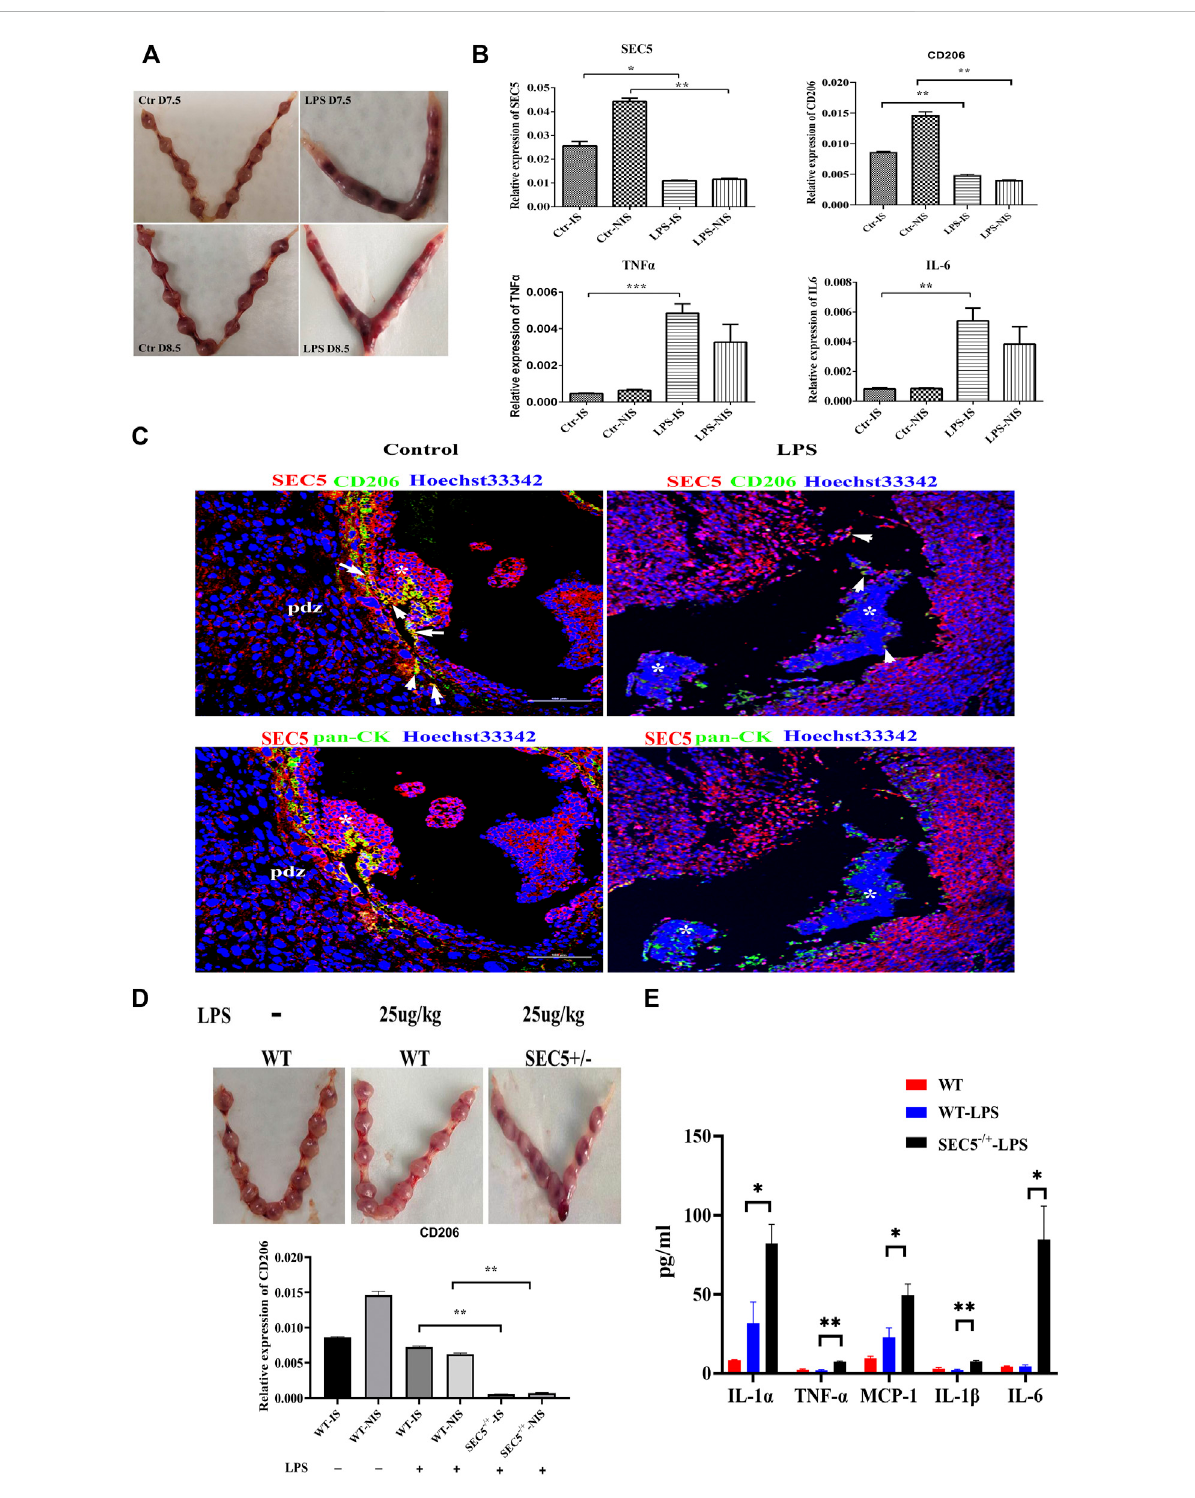
FIGURE 6 UterineexpressionofSEC5isdecreasedinmicewithLPS-inducedearlypregnancyloss. (A) Representativeimagesoftheuterus(GD7.5andGD 8.5)fromasaline-injectedmouse(Ctr)andanaborteduterus(GD7.5andGD8.5)fromanLPS-injectedmouse(LPS)areshown.Theembryomortality rate induced by LPS (250 μ g/kg) was 100%. (B) Uterine expression levels of SEC5, CD206, TNF α and IL-6 determined by qRT – PCR. Ctr-IS: implantation sites of the GD 7.5 saline-injected mice; Ctr-NIS: nonimplantation sites of the GD 7.5 saline-injected mice; LPS-IS: